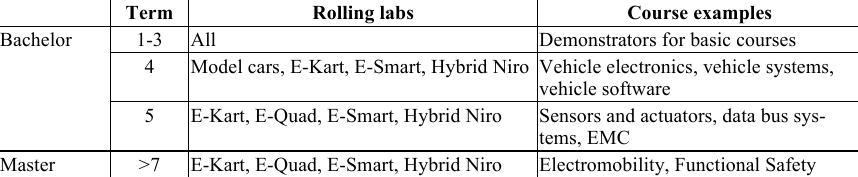
Table 3. Integration of the rolling labs in the curriculum of vehicle electronics at UAS Aachen Term Rolling